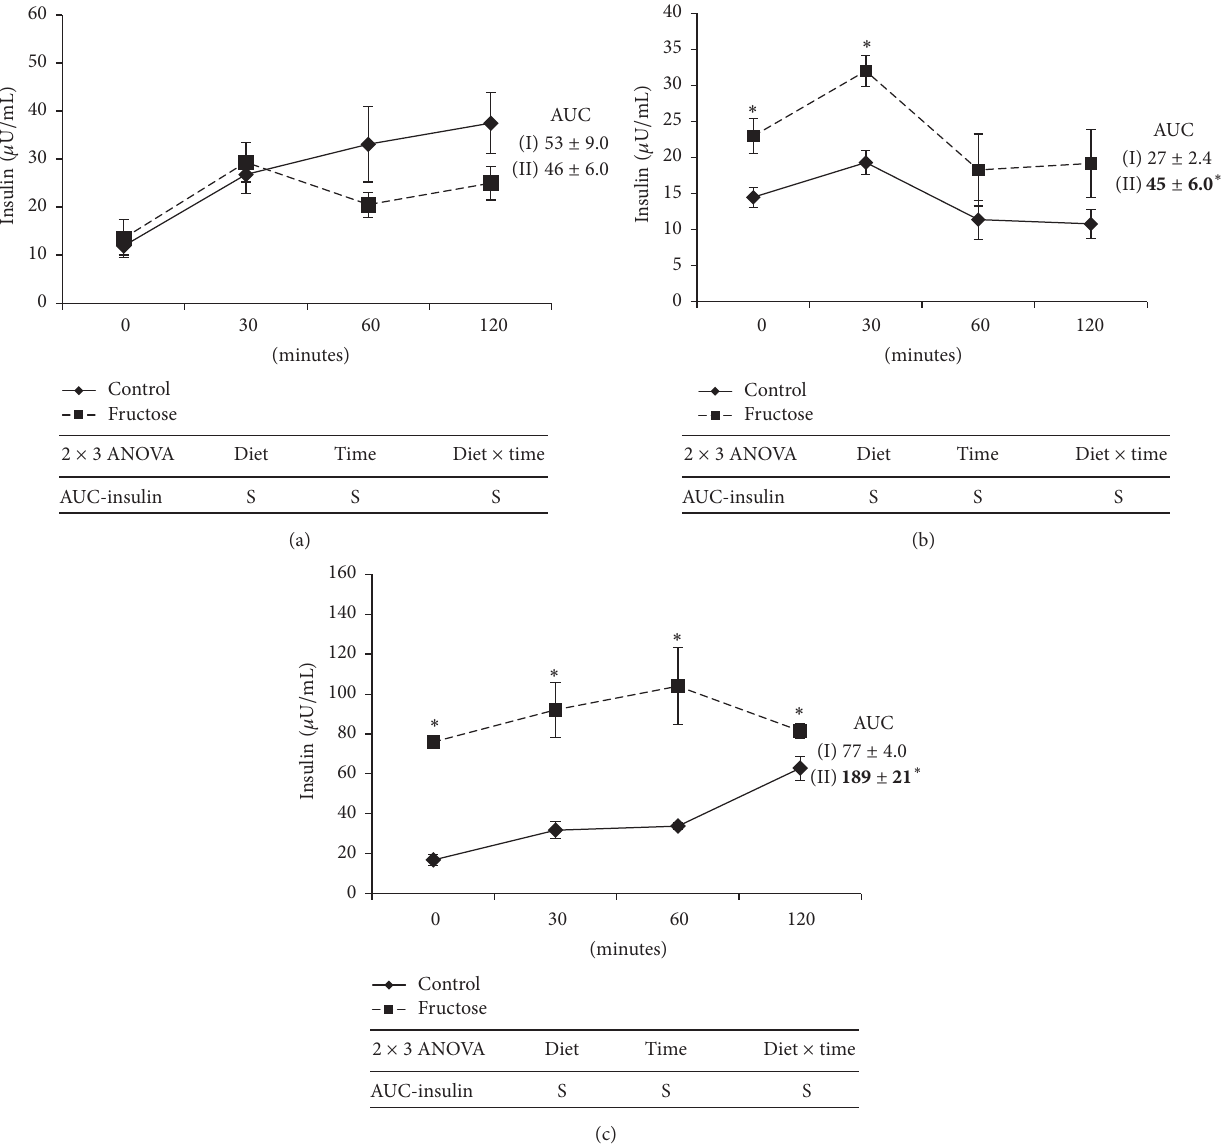
Figure 2: Plasma insulin responses to an oral glucose load in control and fructose diet-fed rats. (a) 4 weeks. (b) 12 weeks. (c) 24 weeks. (—) Control group. (----) High-fructose-fed group. Values are in mean ± SE of 8 animals from each group at all time points. ∗ Significance at 𝑝 ≤ 0.05 by Student’s 𝑡 -test. Statistical significance of diet, time, and diet ∗ time on individual parameters is also analyzed by two-way ANOVA. “S” indicates “significant” ( 𝑝 ≤ 0.05 ); “NS” indicates “not